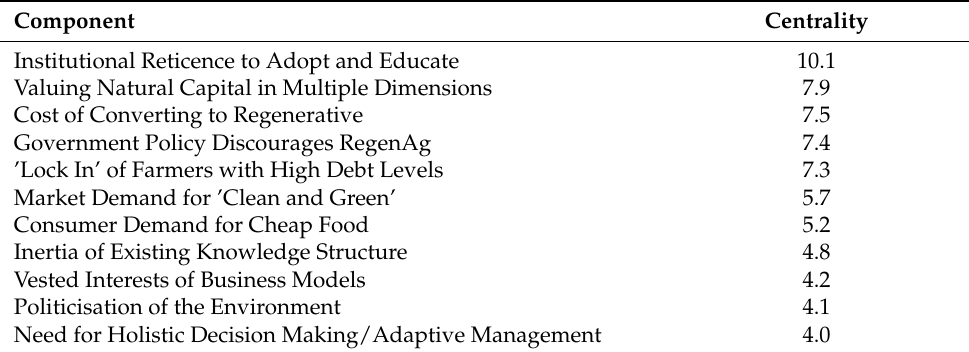
Table 2. FCM results